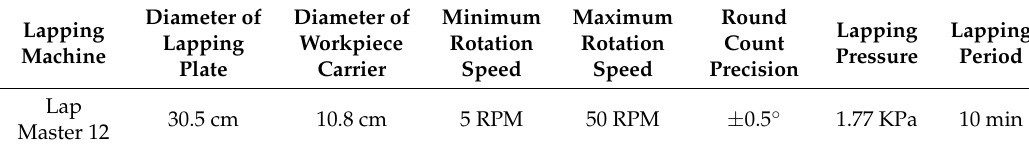
Figure 4. ( a ) The experimental setup and ( b ) schematic diagram of the machining performance test on ceramic workpieces. Table 4. Process parameters of machining tests on the ceramic workpiece.